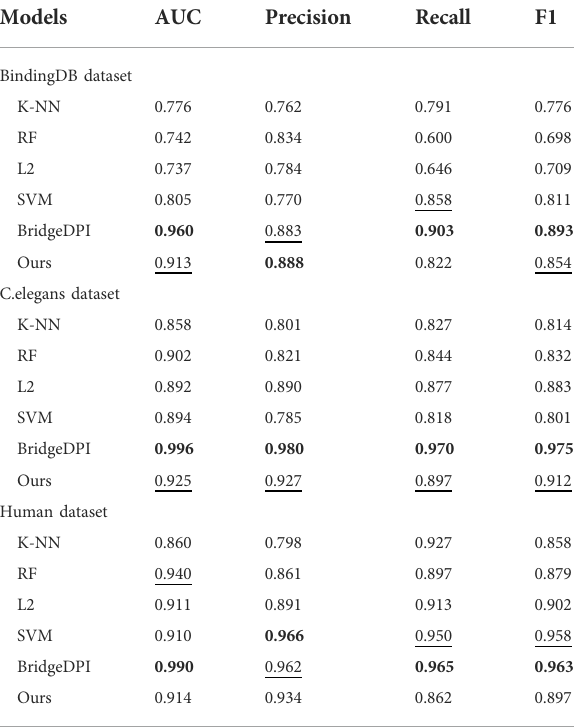
TABLE 2 AUC,precision,recall,and F1valuesobtained under different methods.